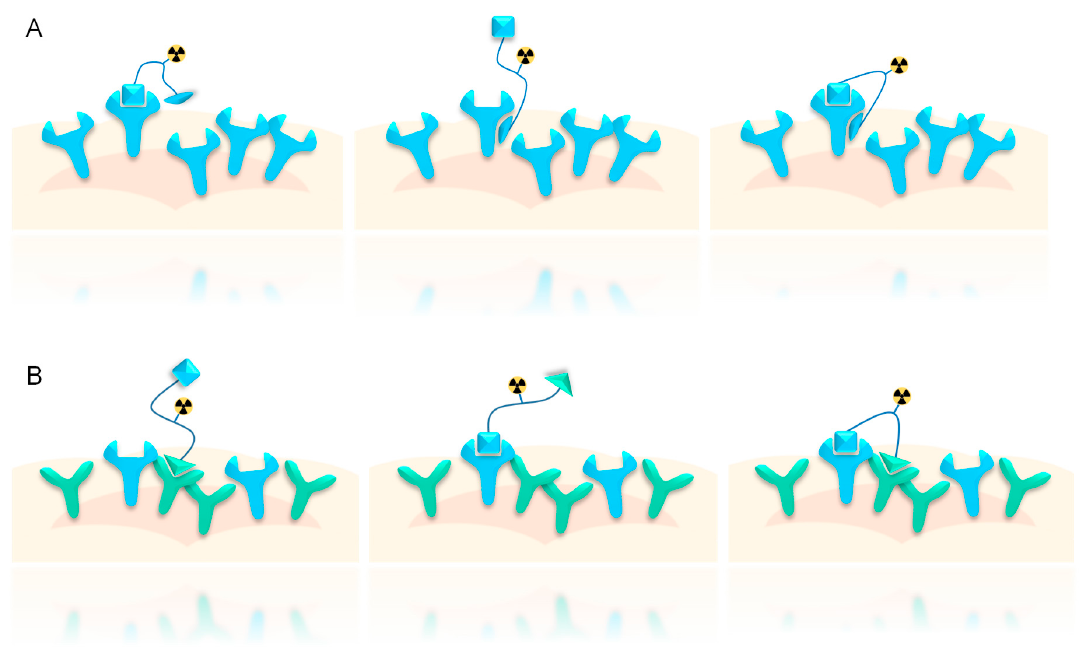
Figure 2. Schematic depiction of bitopic ( A ) vs. heterobivalent ( B ) binding. In the case of bitopic binding, two different binding sites (at least one being allosteric) on the same receptor are addressed by the radioligand, whereas in the case of heterobivalent binding, two orthosteric binding sites of two different receptors are bound.